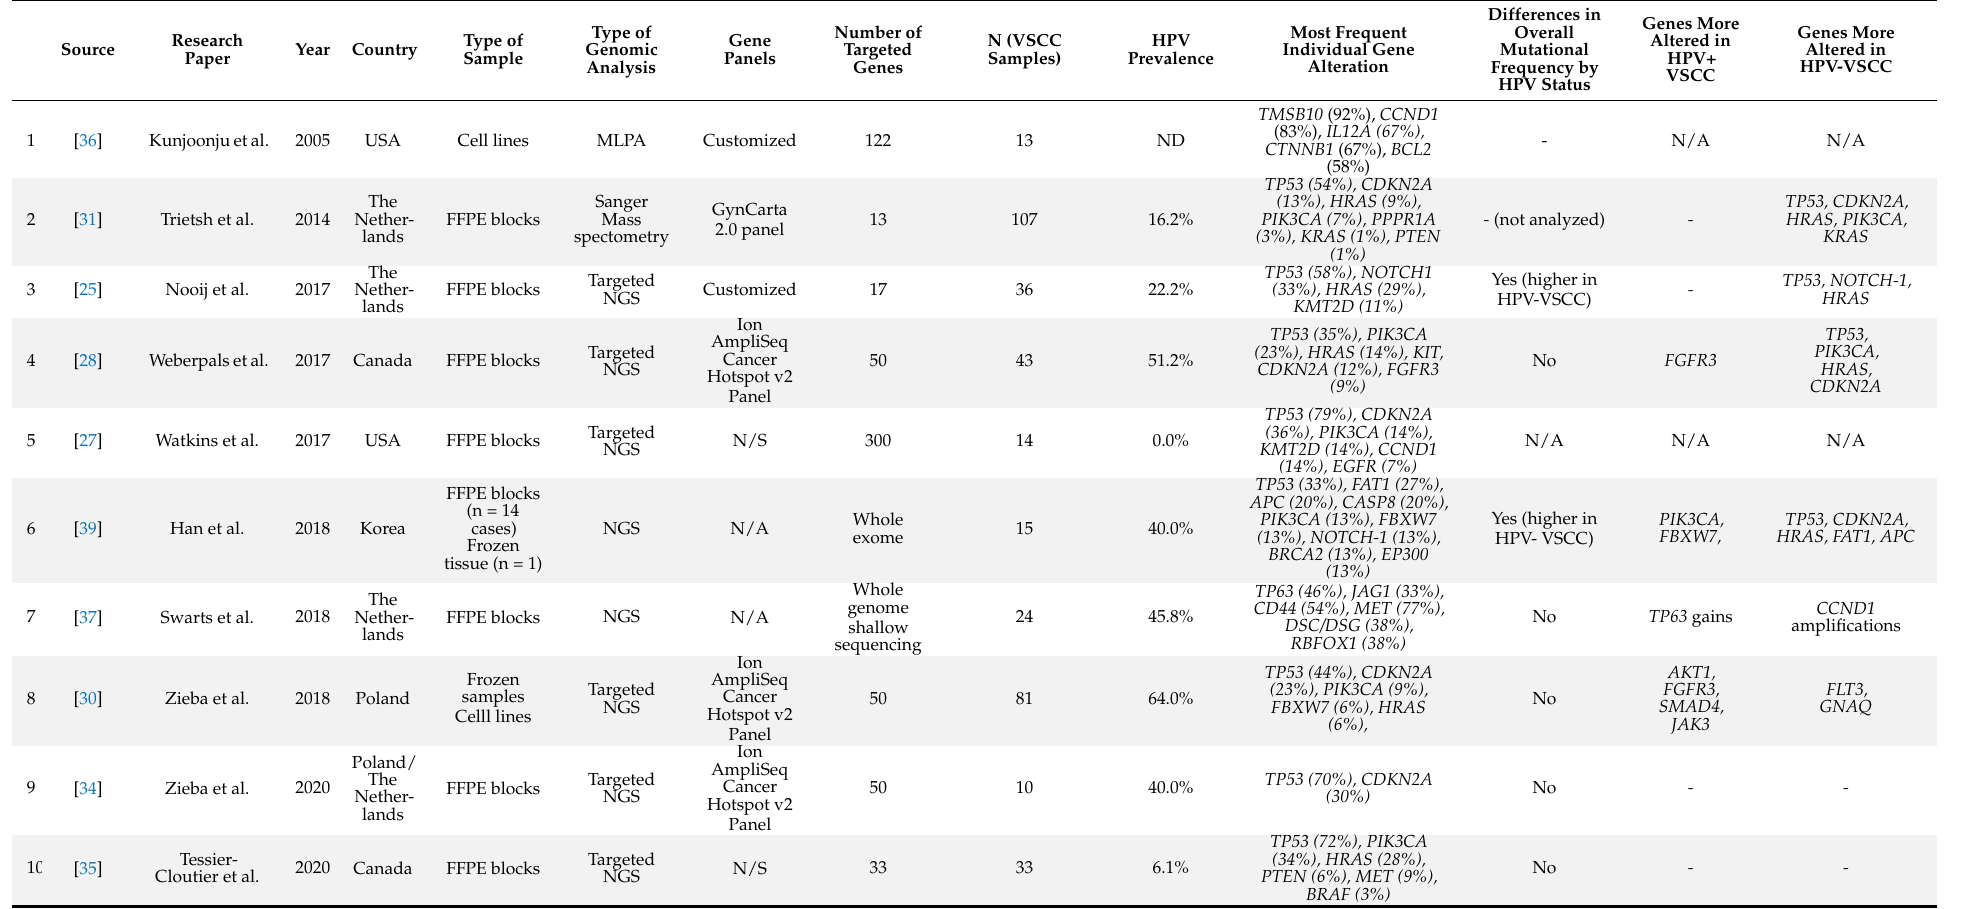
Table 1. Main characteristics of the studies analyzing the genomic alterations in vulvar squamous cell carcinomas